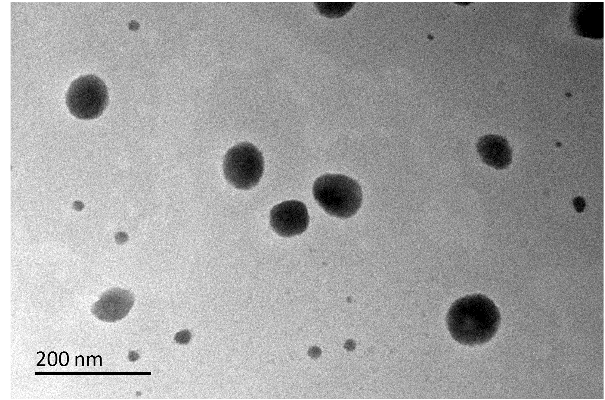
Figure 7. TEM image of PPD-S/T-MM-2.0.